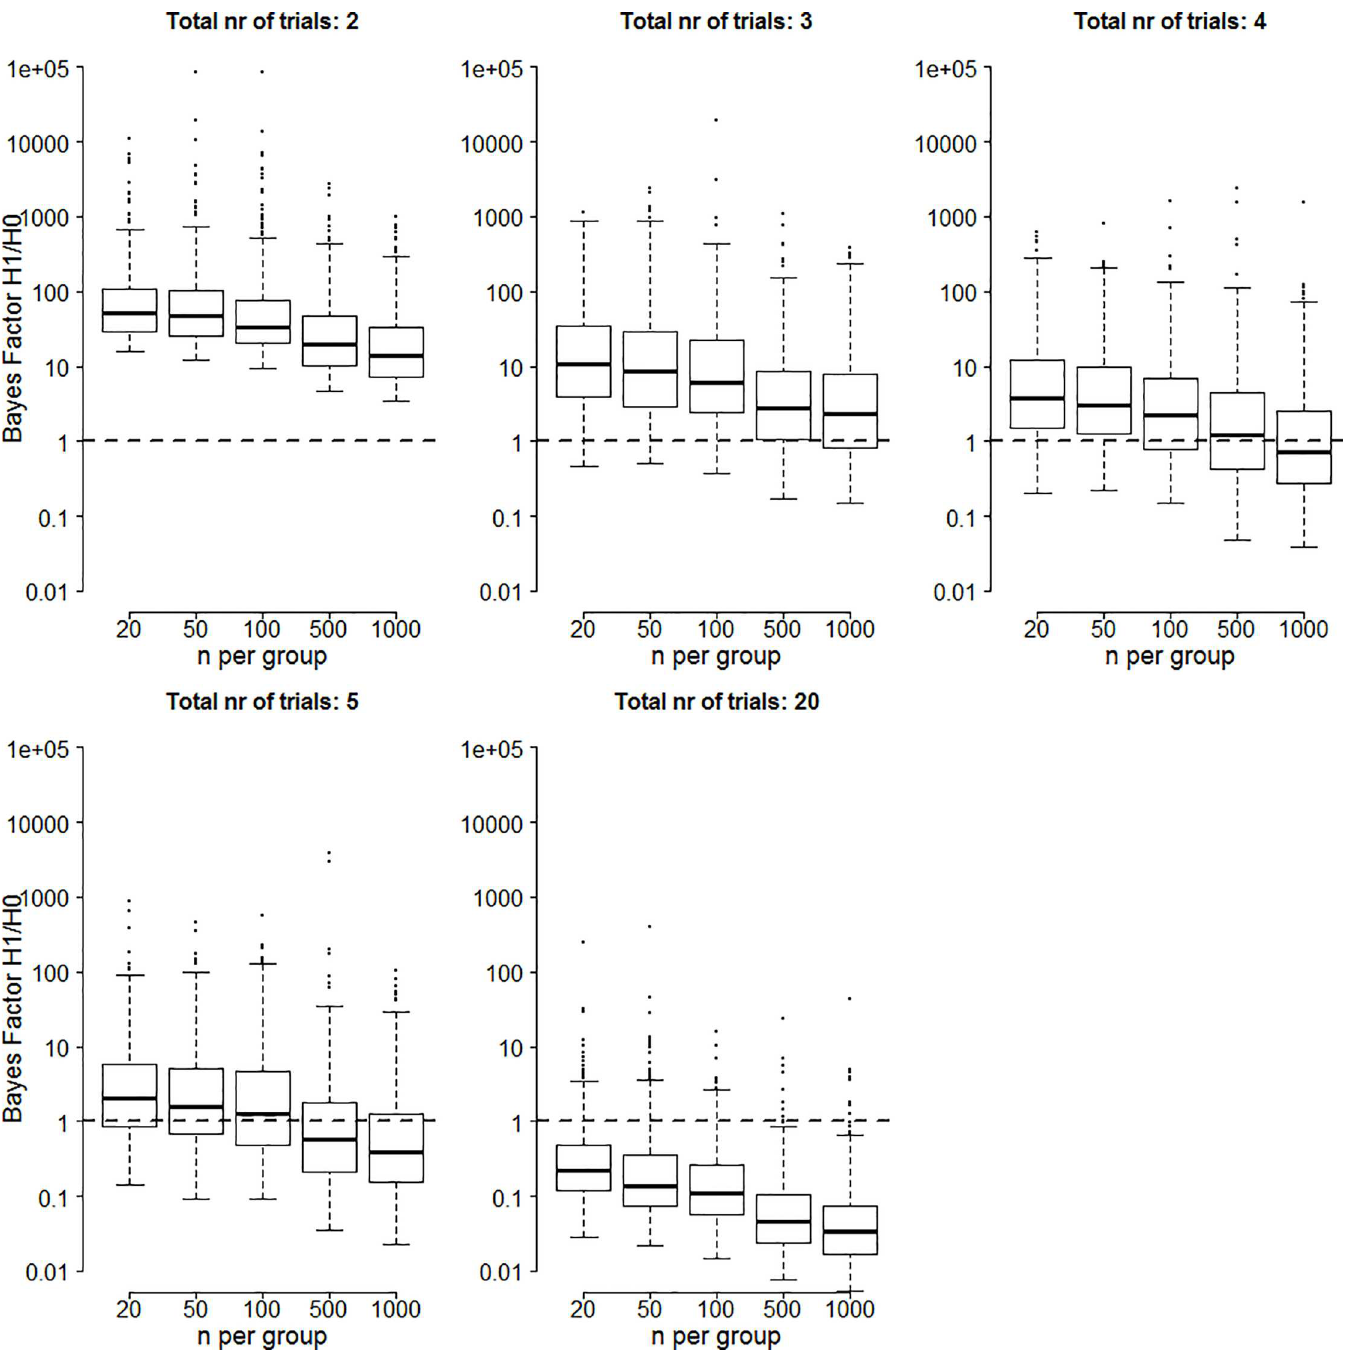
Fig 5. Bayesfactors in favor of the alternative hypothesis for two significant trials when the true effect size is 0. Boxes contain Bayes factors for 50% of the simulations with tails extendingto Bayes factors for 100% of the simulations excludingoutliers. Circles indicateoutliers and are those values more than 1.5 * IQRremoved from the